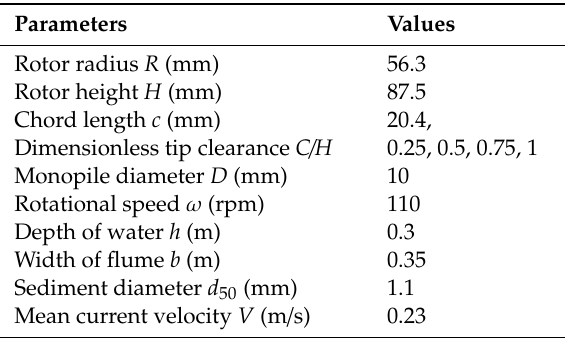
Figure 7. Experimental setup of turbine scour tests: ( a ) overall setup of experimental installation [9]; ( b ) design diagrams of experiment. Table 2. Experimental parameters.